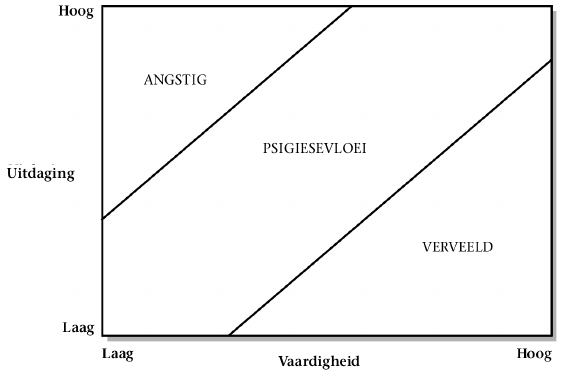
Figuur 1: ’n Driekanaalmodel van psigiesevloei (aangepas uit Csikszentmihalyi, 1992, p.